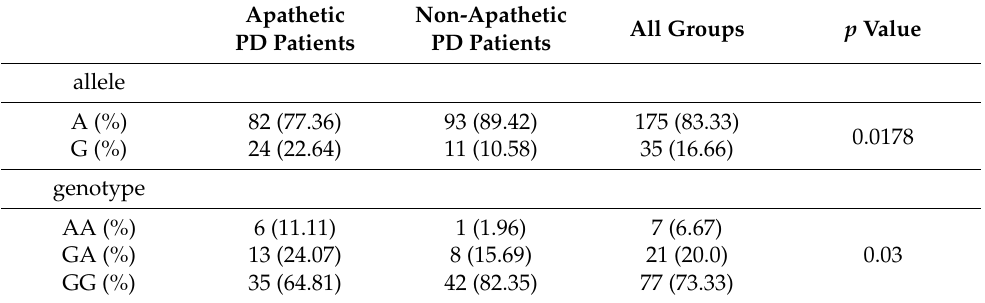
Table 2. The BDNF rs6265 G > A genotype in apathetic and non-apathetic PD patients. Apathetic PD